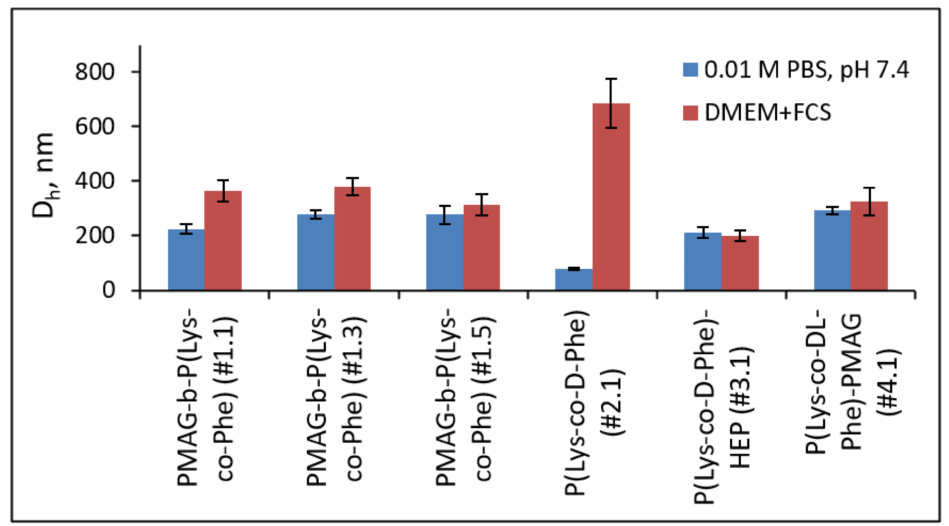
Figure 6. Hydrodynamic diameters of different nanoparticles (C = 0.1 mg/mL) in the buffer solution (0.01 M PBS, pH 7.4) and culture medium (DMEM + 10% FCS ( v / v ). The compositions of different polymer samples are provided in Table